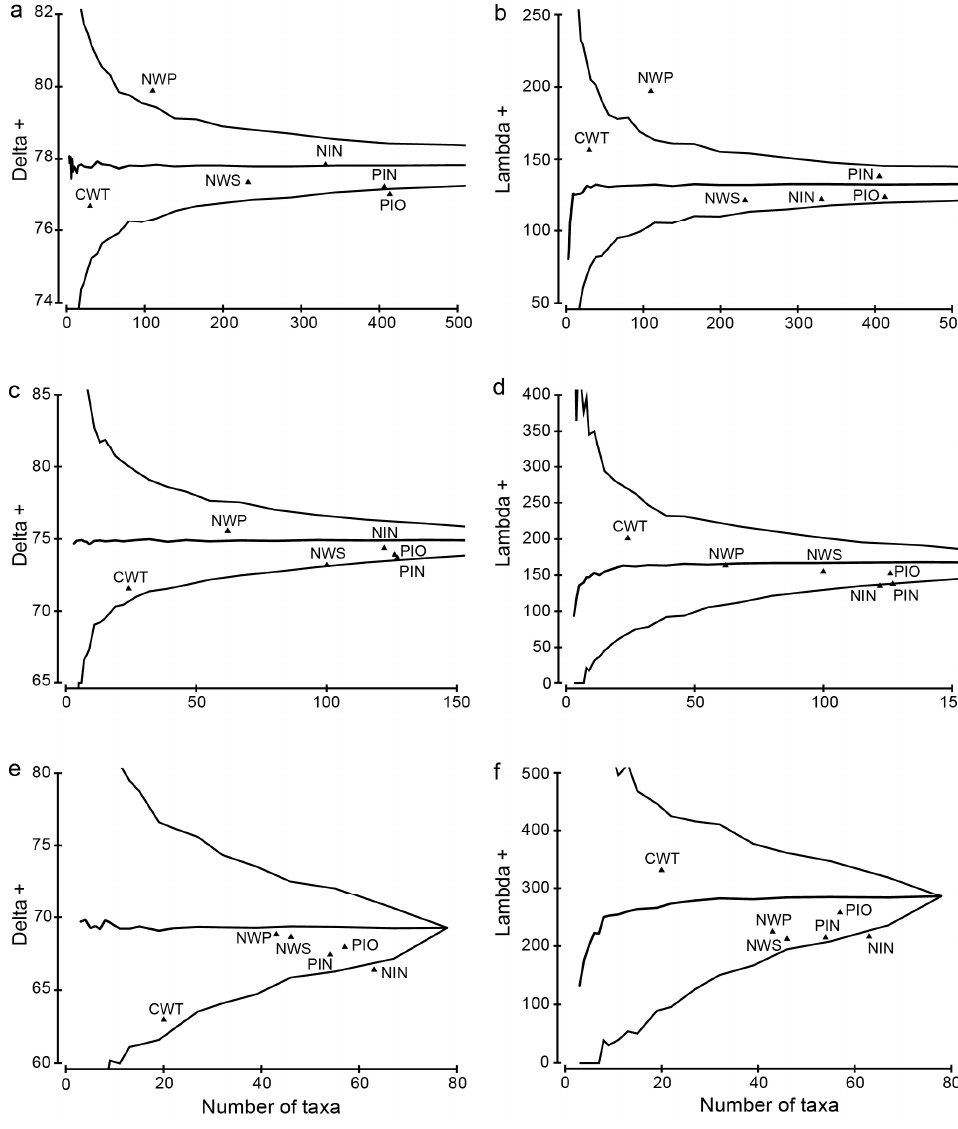
Figure 8. Probability funnels (95% confidence interval) of average taxonomic distinctness (delta +) and variation in taxonomic distinctness (lambda +) values for species-level ( a , b ), genus-level ( c , d ) and family-level taxa ( e , f ). The middle horizontal lines represent the simulated means for the study area from 1000 random selections from the master list of 1164 species for each sub-list. Intervals within which 95% of the simulated values are represented by a probability funnel (outer solid lines). PIN–Pilbara Nearshore, PIO–Pilbara Offshore, NIN–Ningaloo, NWS–Northwest Shelf, NWP–Northwest Province and CWT–Central West